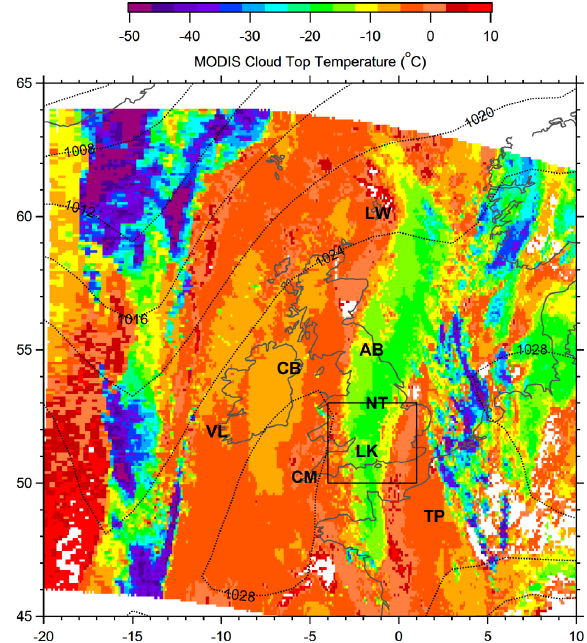
Fig. 2. Colour plot of MODIS derived cloud top temperature from the 11:20 UTC Terra overpass on 18 February 2009. Data have been remapped onto a 0 . 1 ◦ cartesian grid using nearest neighbour values. Surface pressure contours (4mBar intervals) from the ECMWF in- terim reanalysis dataset are shown in black dashed